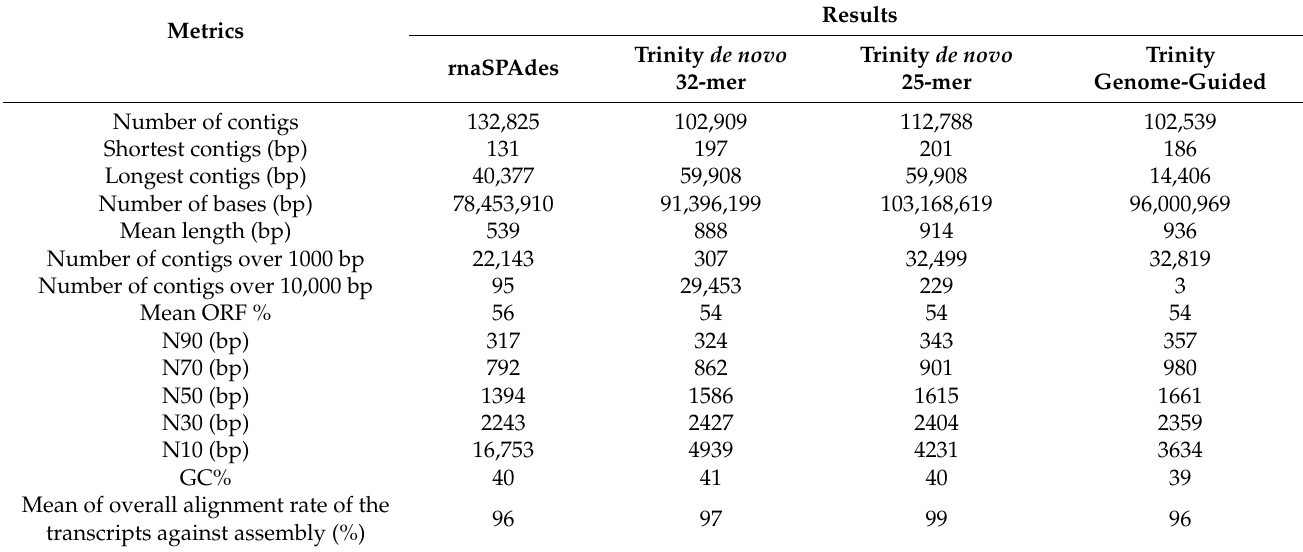
Table 2. Results reflecting assemblies’ parameters obtained by Transrate.